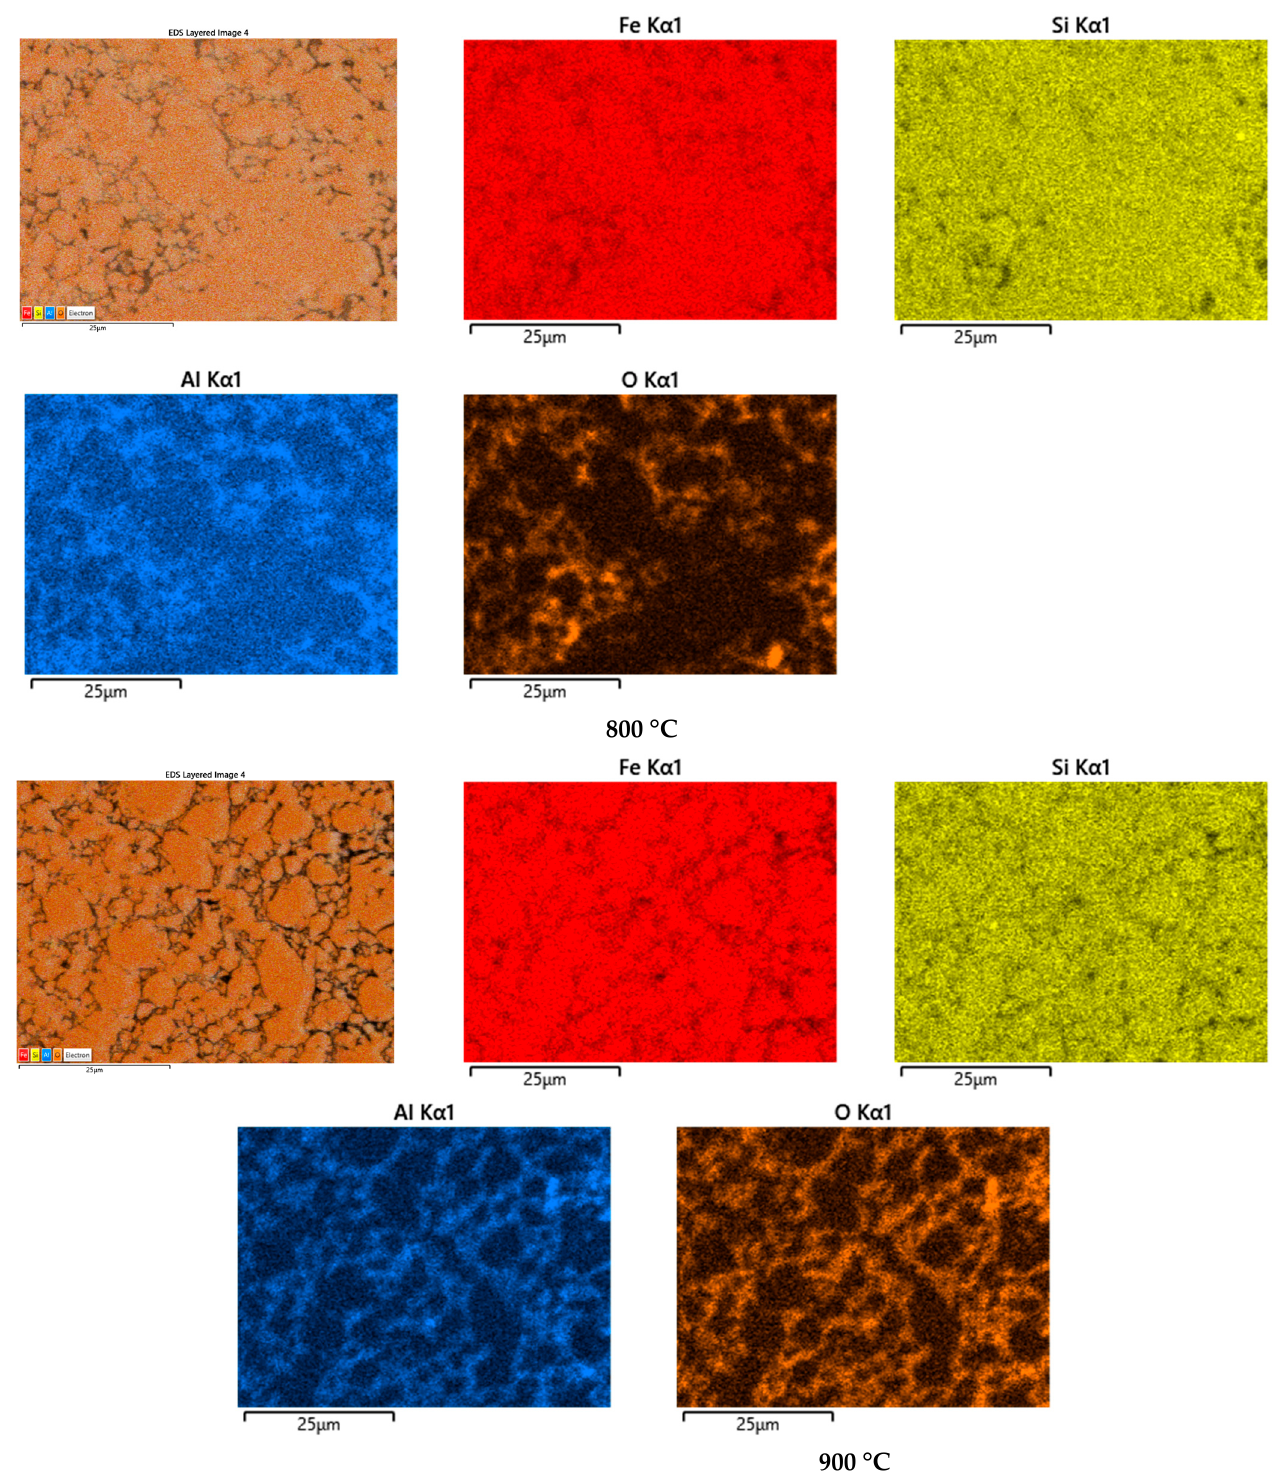
Figure 6. Chemical elements’ distribution maps of the compacts sintered at 800 and 900 °C.